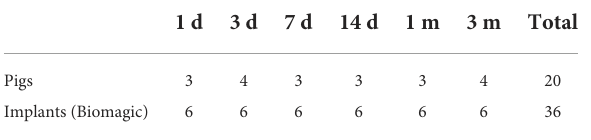
TABLE 4 Summary of studied animals and implanted materials for